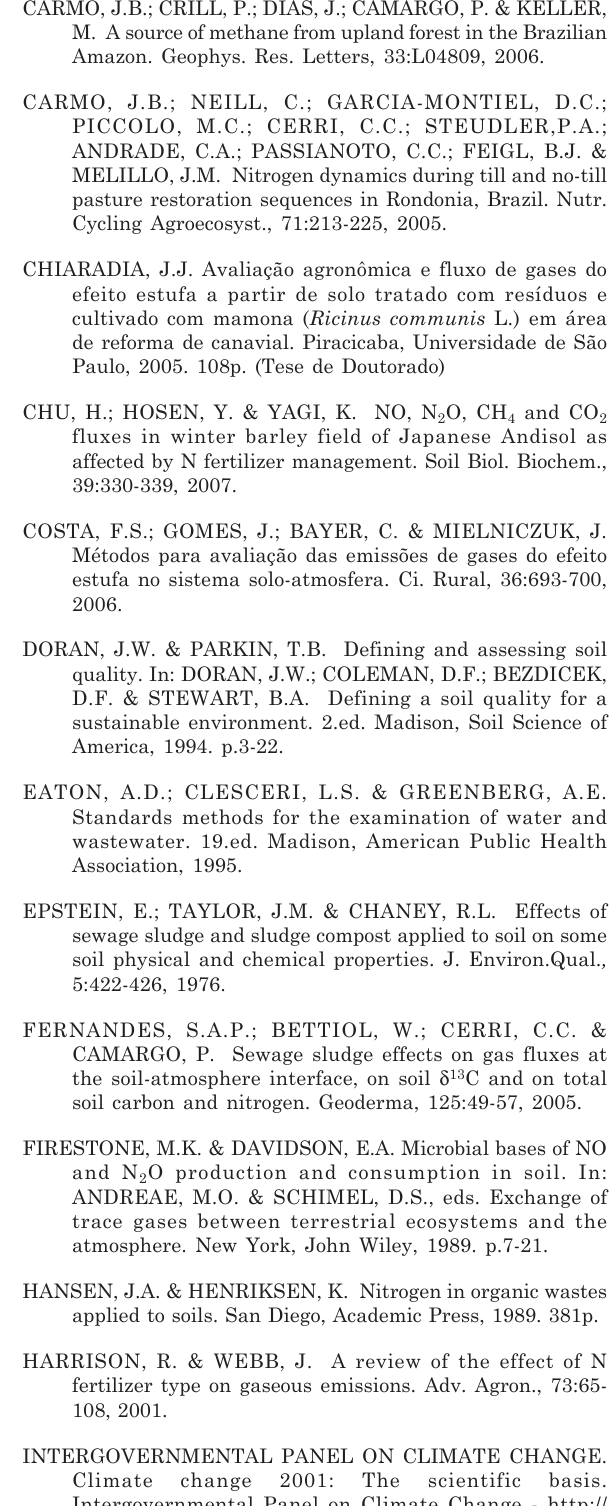
Table 4. Global warming potential (GWP) and carbon emission equivalent (CEE) for an Ultisol treated with sewage sludge (SS) and mineral fertilizer